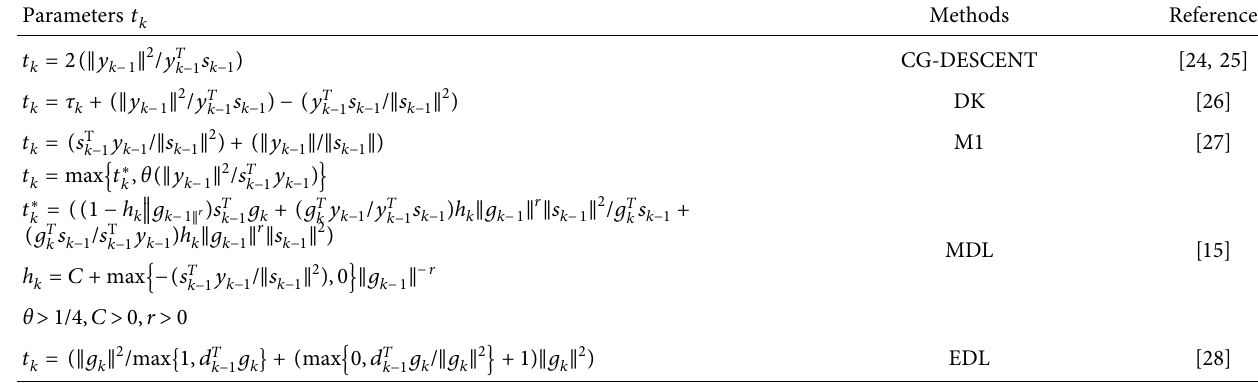
Table 1: Some of the most signifcant rules to determine t